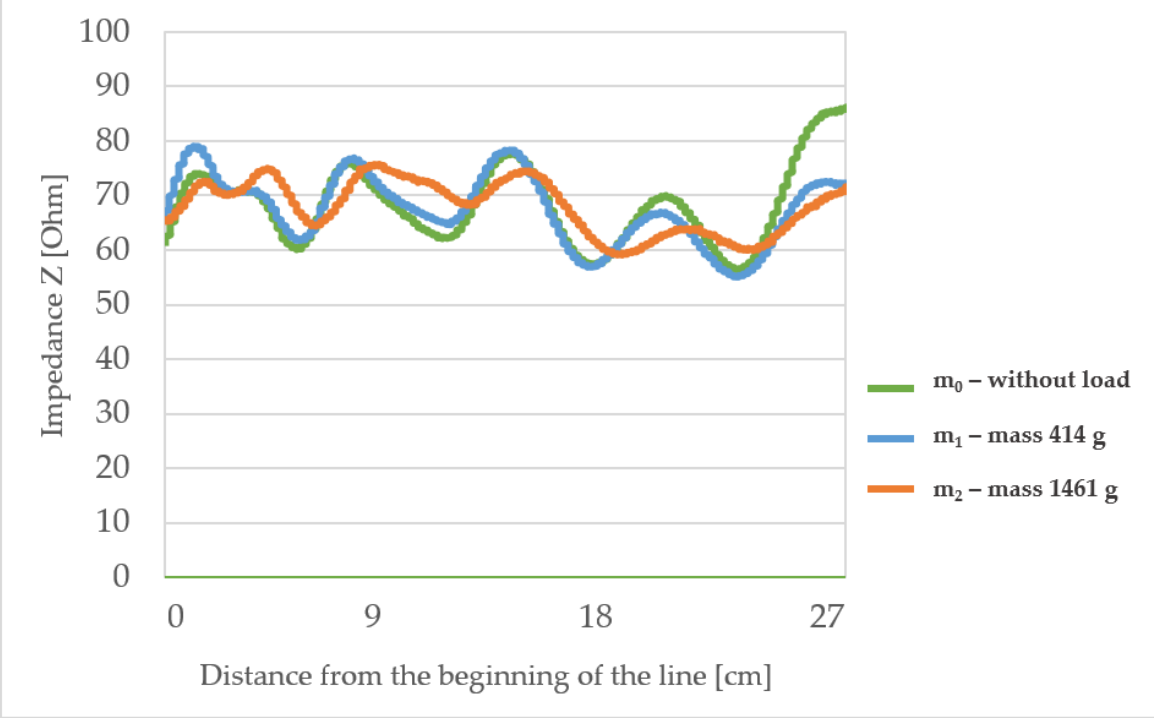
Figure 7. The profiles of the characteristic impedance of the textile signal line L2.